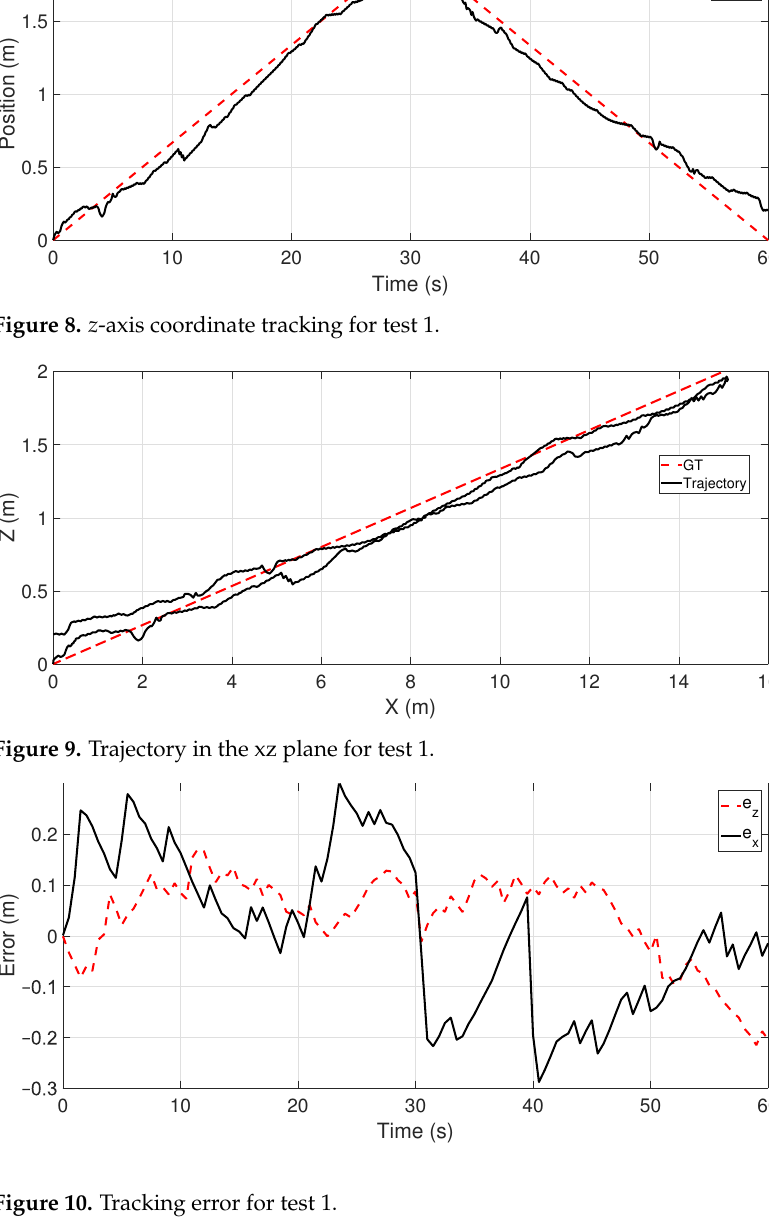
Figure 10. Tracking error for test